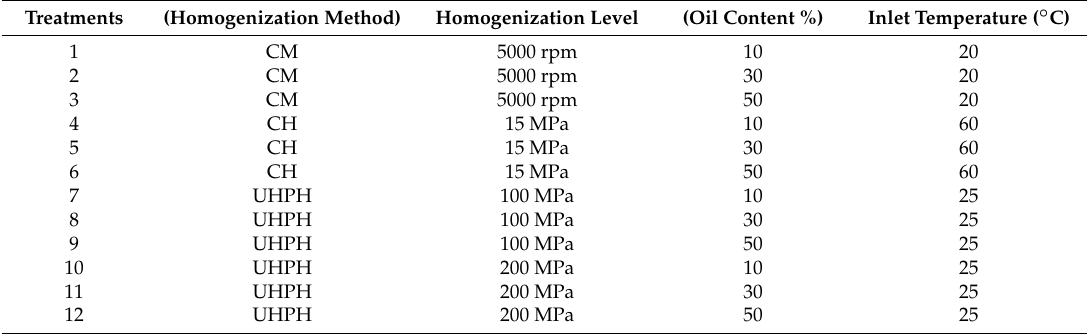
Table 1. Experimental design used in emulsion formulation. CM, colloid mill; CH, conventional